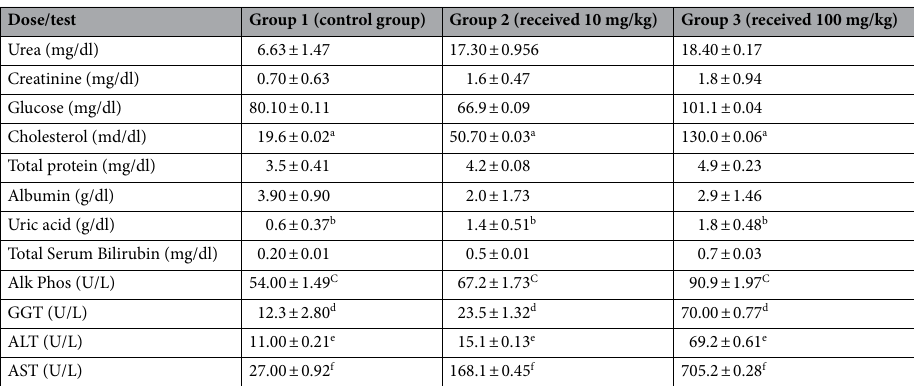
Table 5. Biochemical tests in serum samples of different rats groups. All values are expressed as mean ± SD. Different letters of the same column are significantly different at p < 0.05.